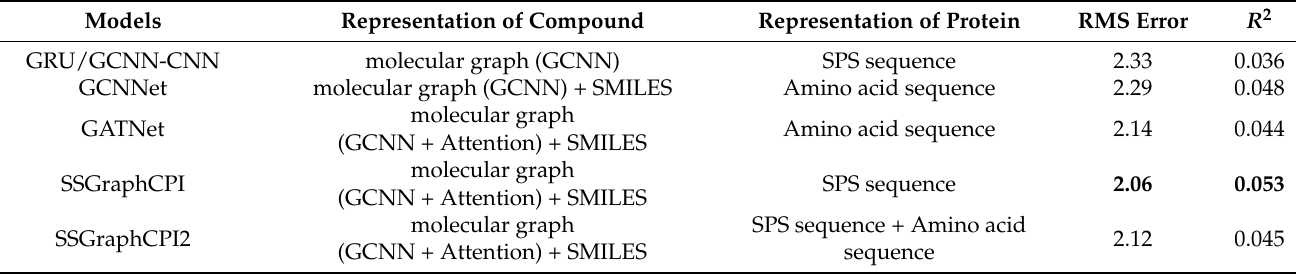
Table 2. RMS errors for different models on ER dataset.